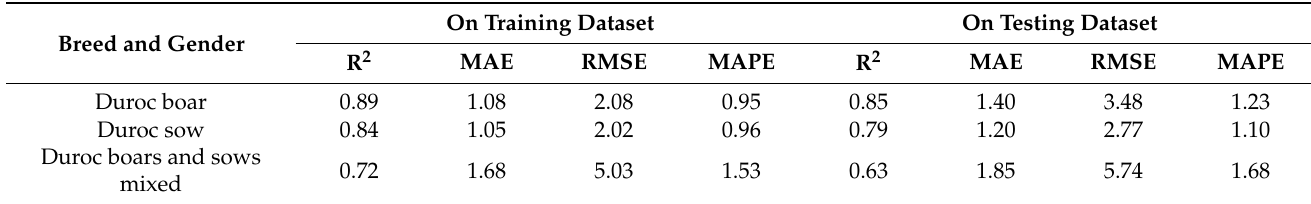
Table 4. Prediction performance of multilayer RBF networks on different